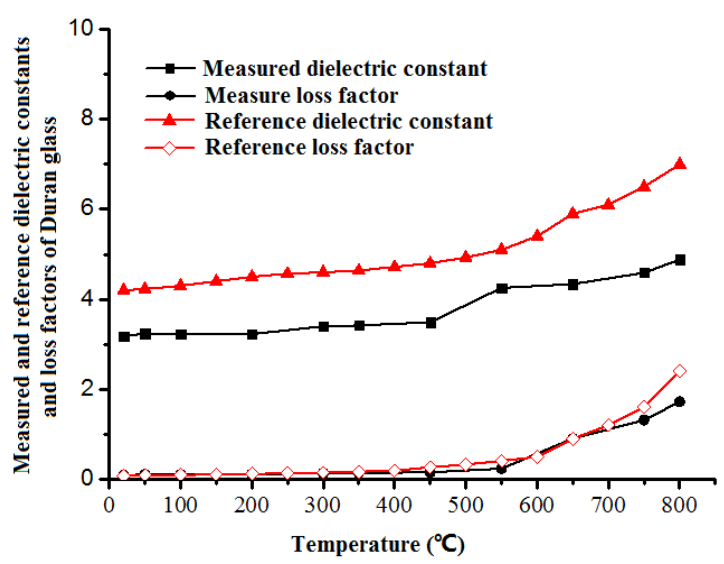
Figure 6. Comparison of measured and reference dielectric properties of Duran glass.